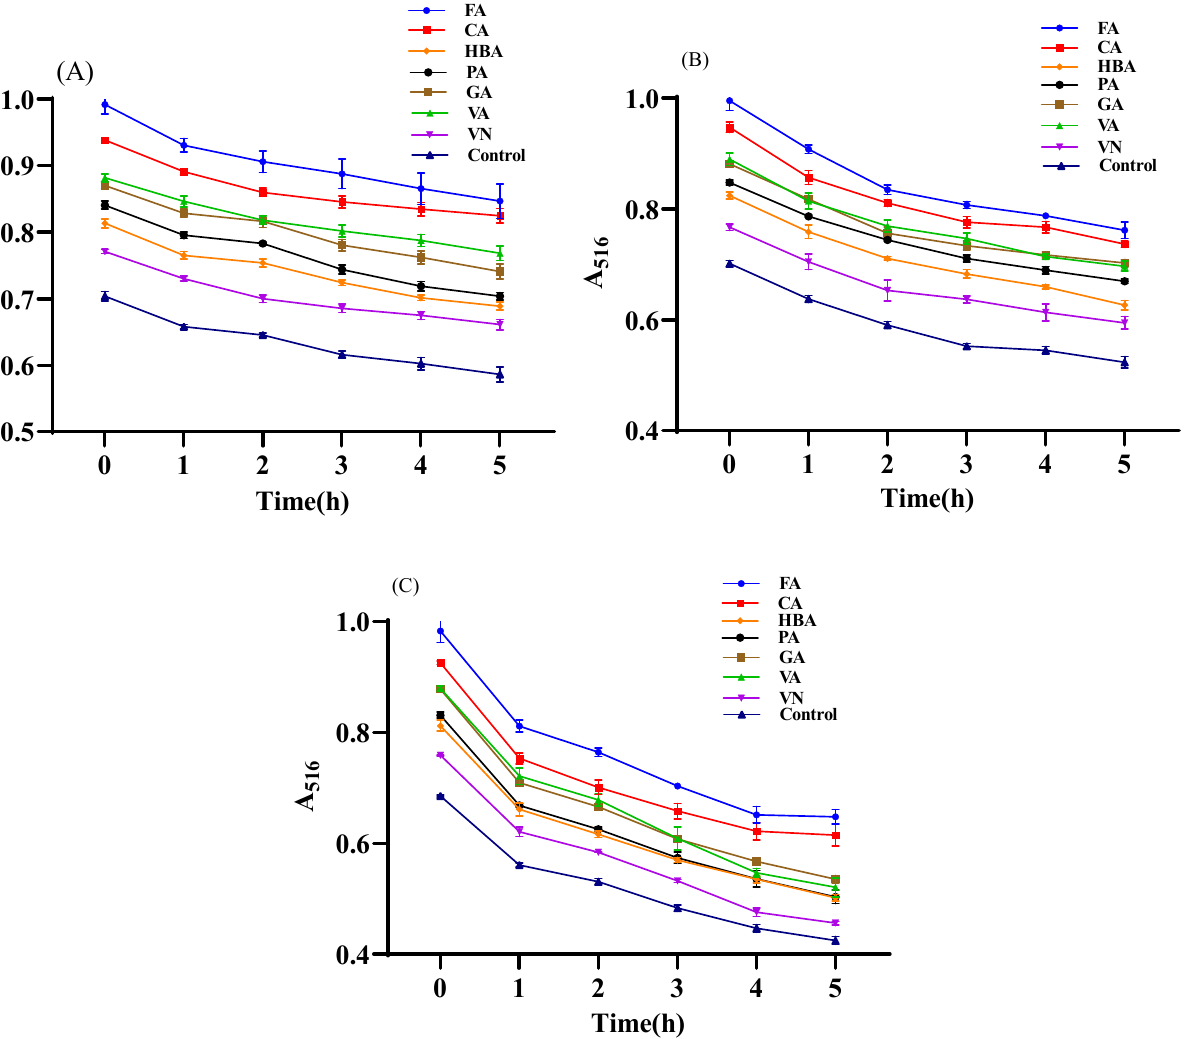
Figure 6. Thermal degradation of mulberry anthocyanins at different temperature (( A ): 70 °C, ( B ): 80 °C, ( C ): 90 °C).